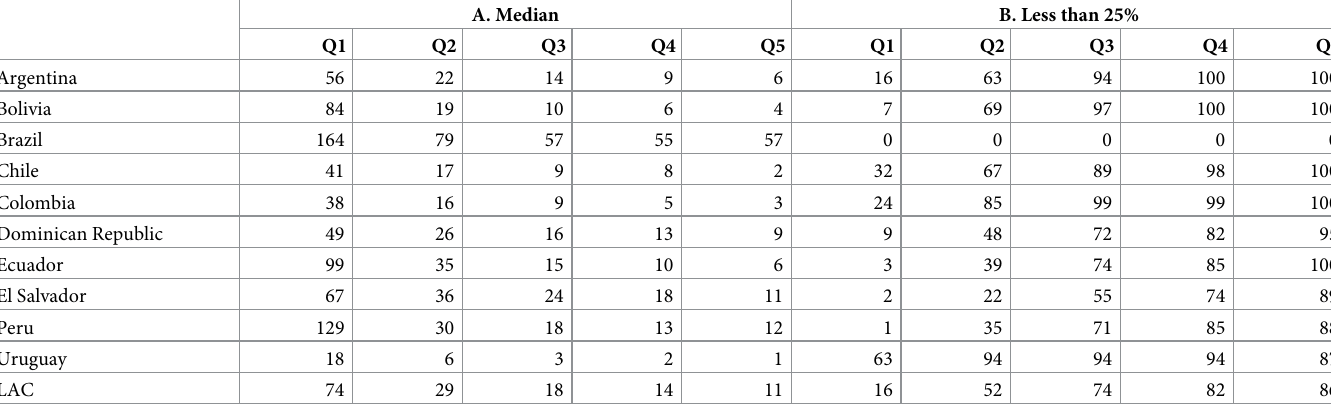
Table 6. Replacement rate of COVID-19 emergency social assistance by country and income